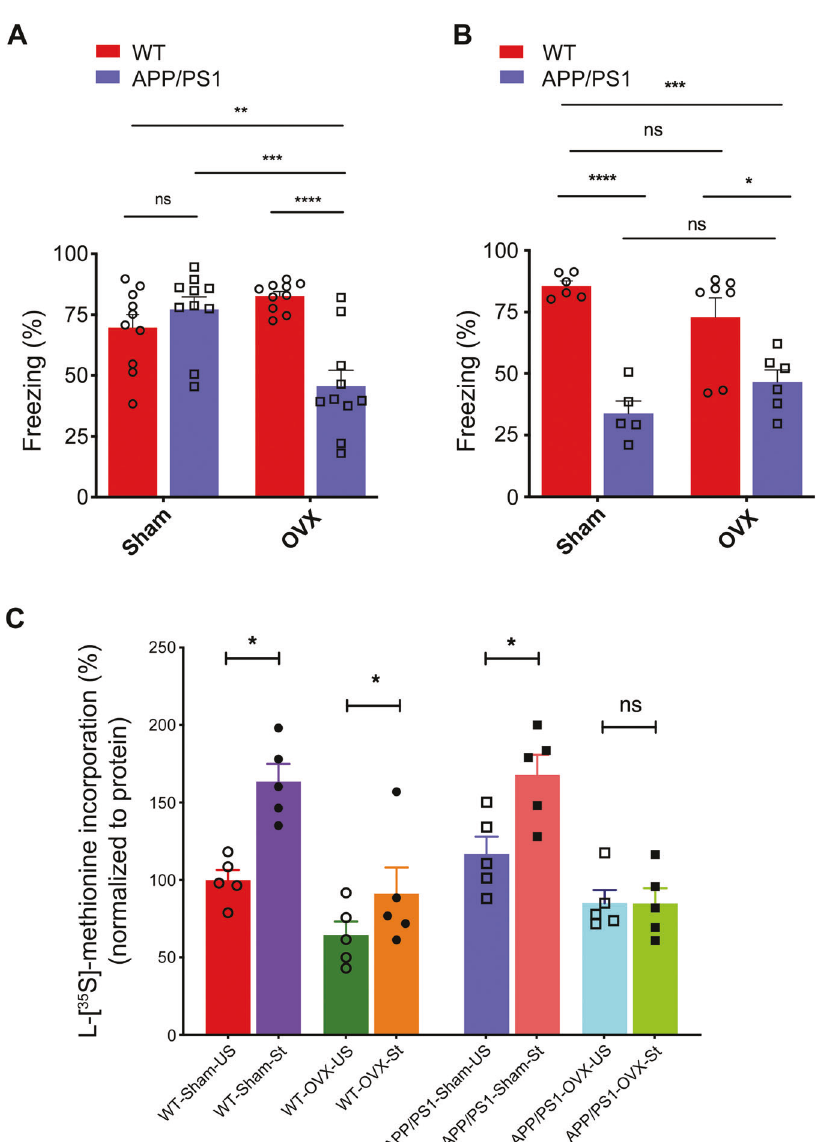
Fig. 2 Ovariectomy persuaded recall de fi cits and induced impairment of local activity dependent protein translation after contextual fear conditioning in APP/PS1 female mice at 4 months of age. Sham or ovariectomized WT and APP/PS1 female mice were subjected contextual fear conditioning at 4- and 8-months age and assessed their recall memory as described in methods section. A Impairment in freezing response was observed in OVX APP/PS1 female mice following contextual fear conditioning at 4 months of age with comparison to all other groups as examined. (WT-Sham versus APP/PS1-Sham, p = 0.7251; WT-Sham versus WT-OVX, p = 0.2798; APP/PS1-Sham versus APP/PS1- OVX, p = 0.0005; WT-Sham versus APP/PS1-OVX, p = 0.0086; WT-OVX versus APP/PS1-OVX, p < 0.0001). Partial Eta squared = 0.353. n = 10 mice per group. B Sham or OVX APP/PS1 female mice exhibit signi fi cantly decreased freezing response than the sham or OVX WT female mice at 8 months of age. n = 5 – 7 mice per group. Statistical comparison is performed using two-way ANOVA. (WT-Sham versus APP/PS1-Sham, p < 0.0001; WT-Sham versus WT-OVX, p = 0.3835; APP/PS1-Sham versus APP/PS1-OVX, p = 0.4522; WT-Sham versus APP/PS1-OVX, p = 0.0005; WT-OVX versus APP/PS1-OVX, p = 0.0146). Partial Eta squared = 0.197. Data are presented as mean ± s.e.m. Statistical signi fi cance indicated as * p < 0.05, ** p < 0.01, *** p < 0.001, **** p < 0.0001. n = 5 – 7 mice per group. Protein translation in synaptoneurosomes from sham or OVX WT and APP/PS1 female mice after KCl stimulation was measured as L-[ 35 S]-methionine incorporation. C L-[ 35 S]-methionine incorporation by KCl stimulation was signi fi cantly increased in synaptoneurosomes from sham WT or APP/PS1 female mice (4 months) than unstimulated synaptoneurosomes. KCl stimulated protein translation was signi fi cantly impaired in synaptoneurosomes from OVX APP/PS1 female mice (4 months) than unstimulated OVX APP/PS1 female mice (4 months). Statistical comparisons from each group (unstimulated versus stimulated) were calculated using paired, one-sided, student t- test. All values normalized to unstimulated WT-sham group. (WT-Sham-US versus WT-Sham- St, t = 5.442 ; df = 4; p = 0.003; Hedges ’ g (95% CI) 2.79 (1.01, 4.51); WT-OVX-US versus WT-OVX-St, t = 2.649; df = 4; p = 0.029; Hedges ’ g (95% CI) 0.79 ( − 0.41, 1.95); APP/PS1-Sham-US versus APP/PS1-Sham-St, t = 6.62; df = 4; p = 0.001; Hedges ’ g (95% CI) 1.69 (0.27, 3.04); APP/PS1-OVX-US versus APP/PS1-OVX-St, t = 0.06526; df = 4; p = 0.476; Hedges ’ g (95% CI) − 0.01 ( − 1.13, 1.10)). Data are presented as mean ± s.e.m. Statistical signi fi cance indicated as * p < 0.05. n = 5 mice per